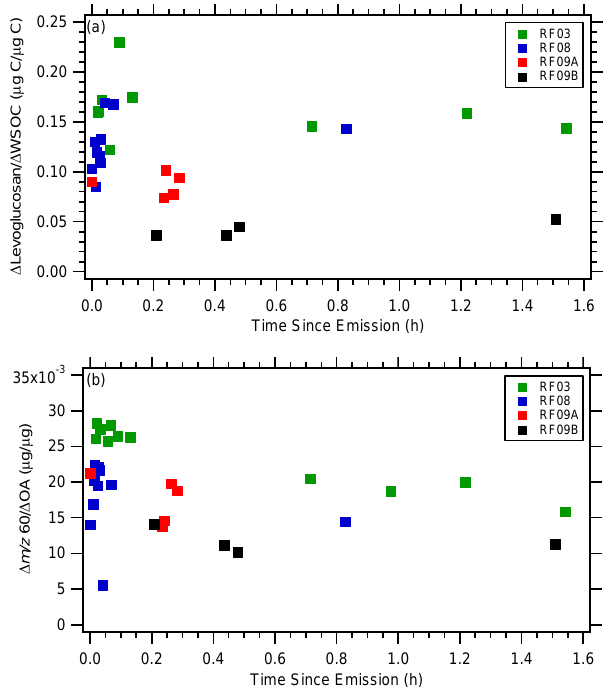
Figure 6. (a) 1 Levoglucosan /1 WSOC ratio on a carbon mass ba- sis and (b) 1m/z 60 /1 OA ratio as a function of time since emis- sion for all flights with the data segregated by fire location.